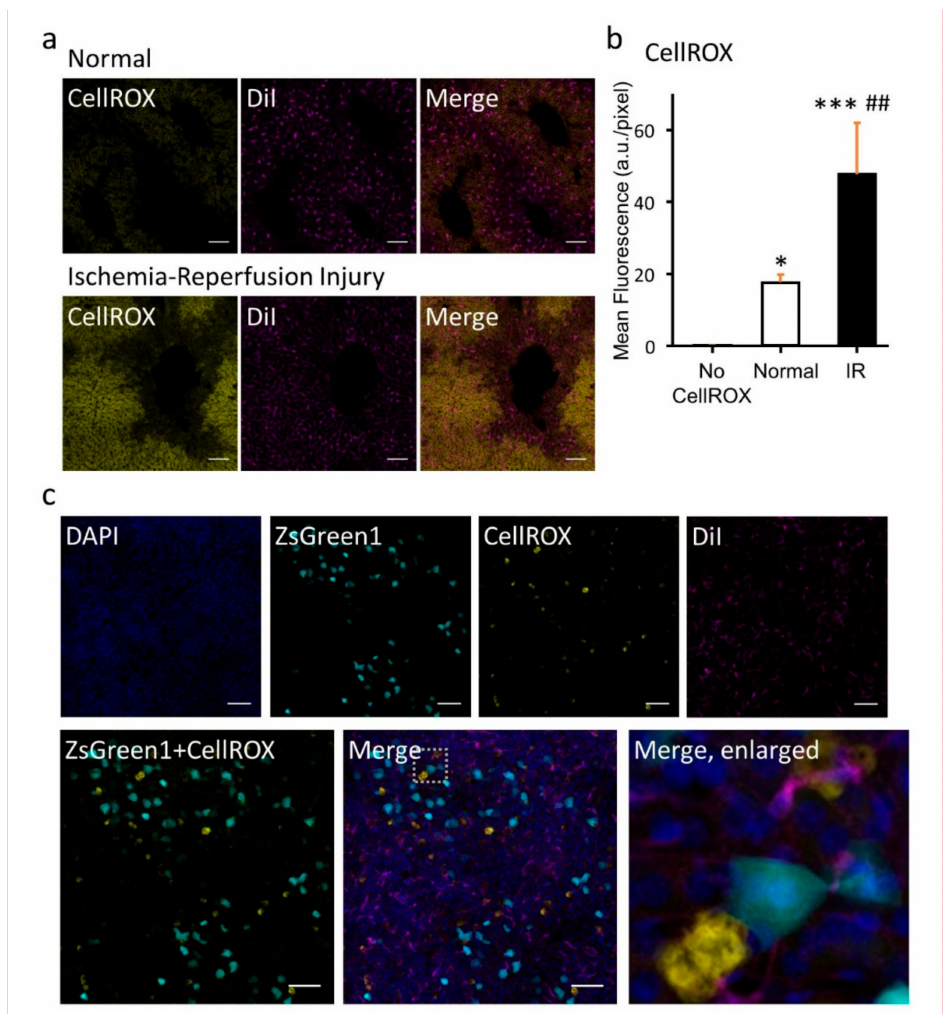
Figure 5. ROS visualization. ( a ) ROS (yellow) were detected using CellROX Deep Red reagent in normal andischemia / reperfusion-injuredlivers. MagentasignalsrepresentDiI-stainedsinusoids. ( b )Numerical conversion of CellROX fluorescence in untreated (no CellROX), normal, and ischemia / reperfusion (IR)-injured livers, calculated by the average of z-stack images (0–40 µ m). Each bar represents the mean + S.D. of four regions. Statistical comparison was performed using Tukey’s test. * p < 0.05, *** p < 0.001 vs. no CellROX group, ## p < 0.01 vs. normal group. ( c ) Relationship between gene expression and ROS after hydrodynamics-based transfection to the liver. Blue, DAPI-stained nuclei. Cyan, gene expression of ZsGreen1. Yellow, ROS detected using CellROX Deep Red. Magenta, DiI-stained sinusoids. Fluorescence images were acquired as a z-stack at ( a ) 1.000- µ m and ( c ) 0.637- µ m intervals using a confocal microscope with a × 40 LD C-Apochromat objective lens. Acquisition settings were as follows: zoom, 1.0; xy scaling, 0.415 µ m; spectral emission filters (bandwidth), 409–484, 494–543, 553–631, and 648–726 nm; laser wavelengths, 405, 488, 543, and 633 nm for DAPI, ZsGreen1, DiI, and CellROX Deep Red, respectively. Each panel represents average intensity projection of ( a ) 40.00 µ m and ( c ) 38.23 µ m in thickness, with a 4 × 4 tile observation. Scale bars represent 100 µ m. Each image was representative of three